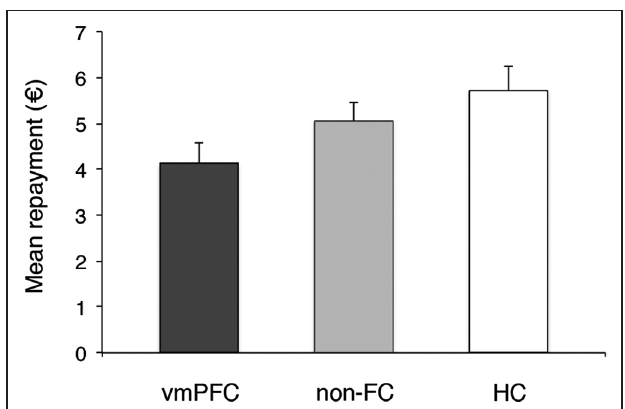
FIGURE 3 | Group’s reciprocity level. Error bars indicate the SEM. vmPFC = ventromedial prefrontal cortex patients; non-FC = control patients; HC = healthy